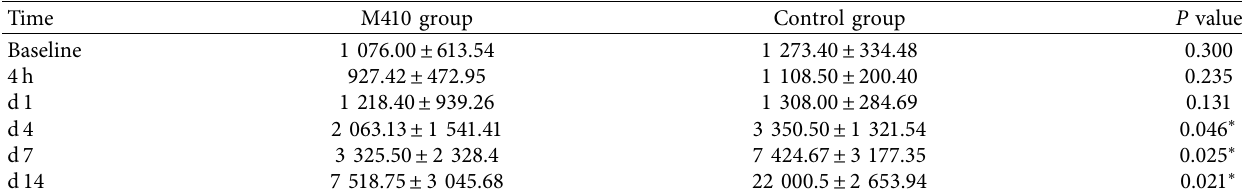
Table 1: Average tumor volume of two groups at each time point (mm 3 ).